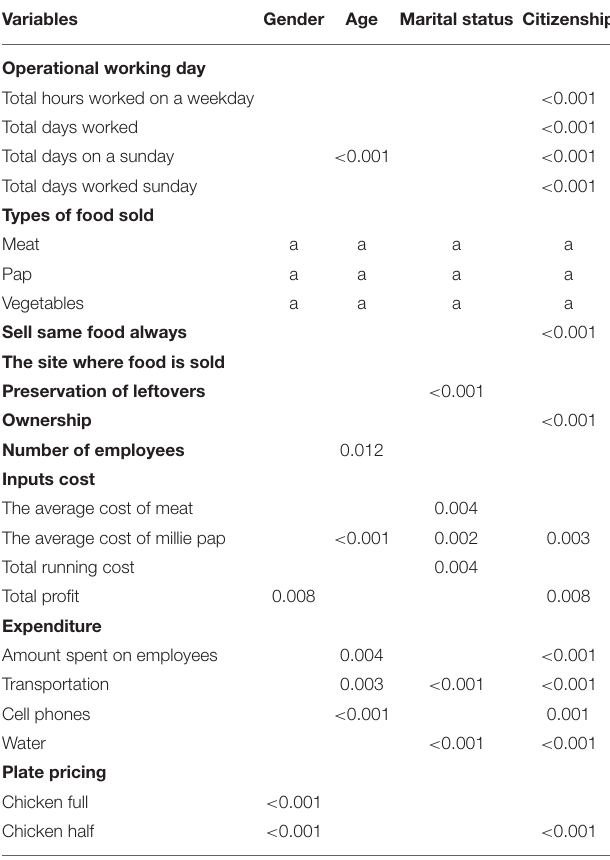
TABLE 9 | Operational variables for which there was a significant difference in the characteristics of the respondents using Bonferroni adjusted